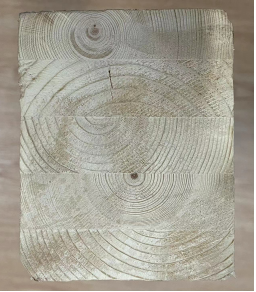
Figure 5. Cross-section of Glulam